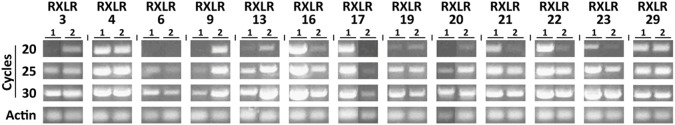
Expression levels of H. arabidopsidis RXLR genes in A. thaliana.
Semi-quantitative analysis of the expression levels of the RXLR transgenes from H. arabidopsidis Waco9 in A. thaliana accession Col-0. Expression levels were assessed in two independent transgenic lines using RXLR gene-specific primers. Depicted are ethidium bromide-stained agarose gels with PCR products after 20, 25 or 30 cycles of PCR amplification. The PCR product of the A. thaliana actin gene (At3g18780) was used as internal control (25 cycles of PCR amplification).